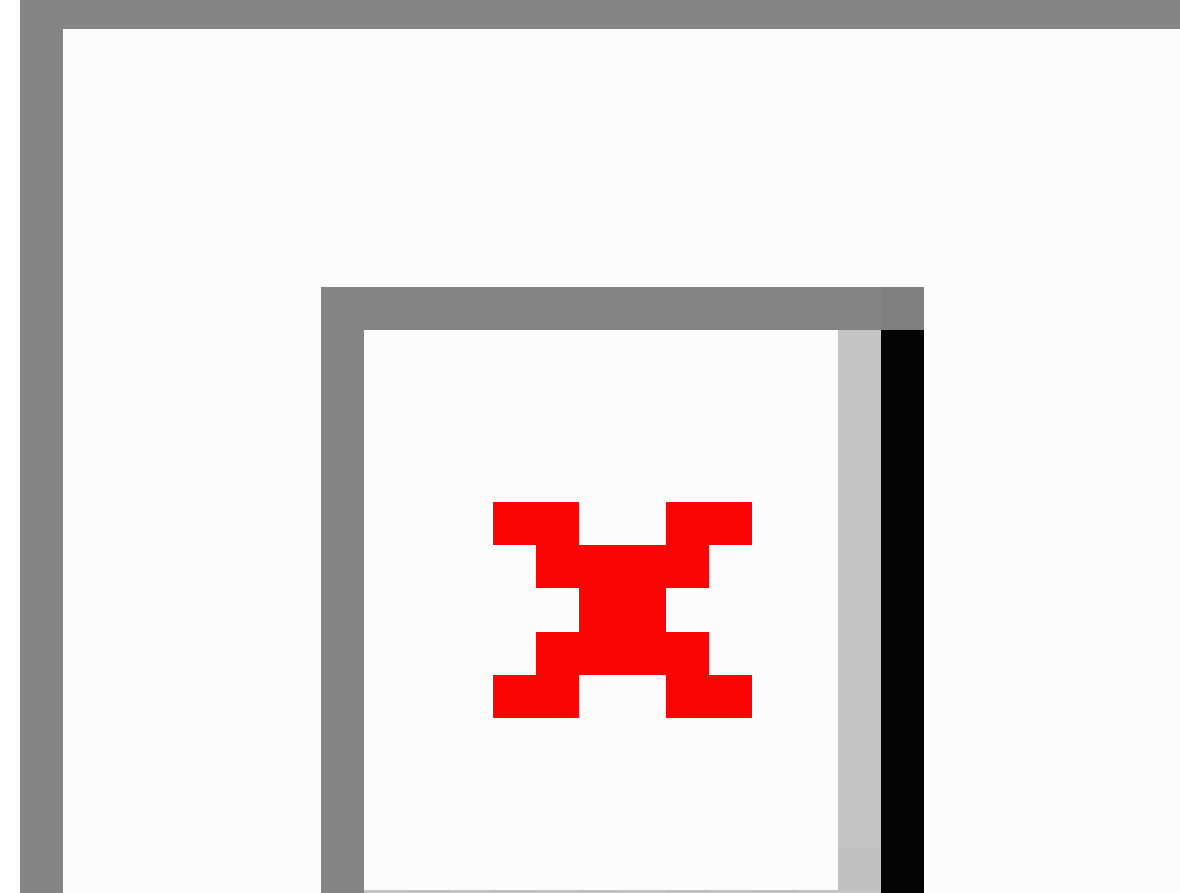
Figure 3. Time series visualization of HIV prevalence in Ethiopia from the years 1990-2010. To visualize other countries, substitute the country name in the